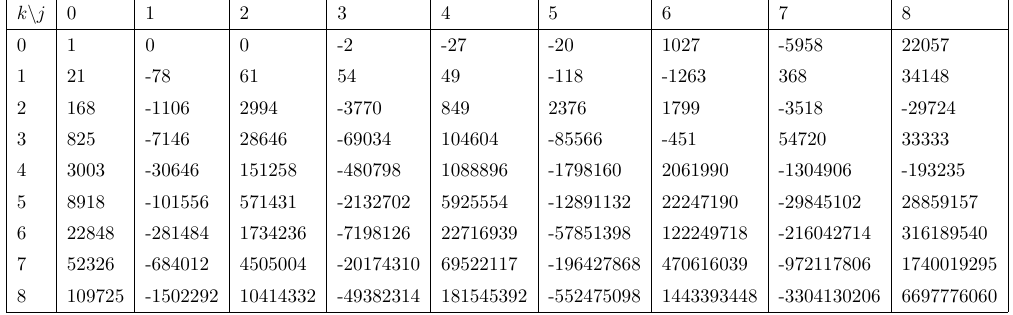
Table 56. Table of b jk coe(cid:14)cients for h SO(7)